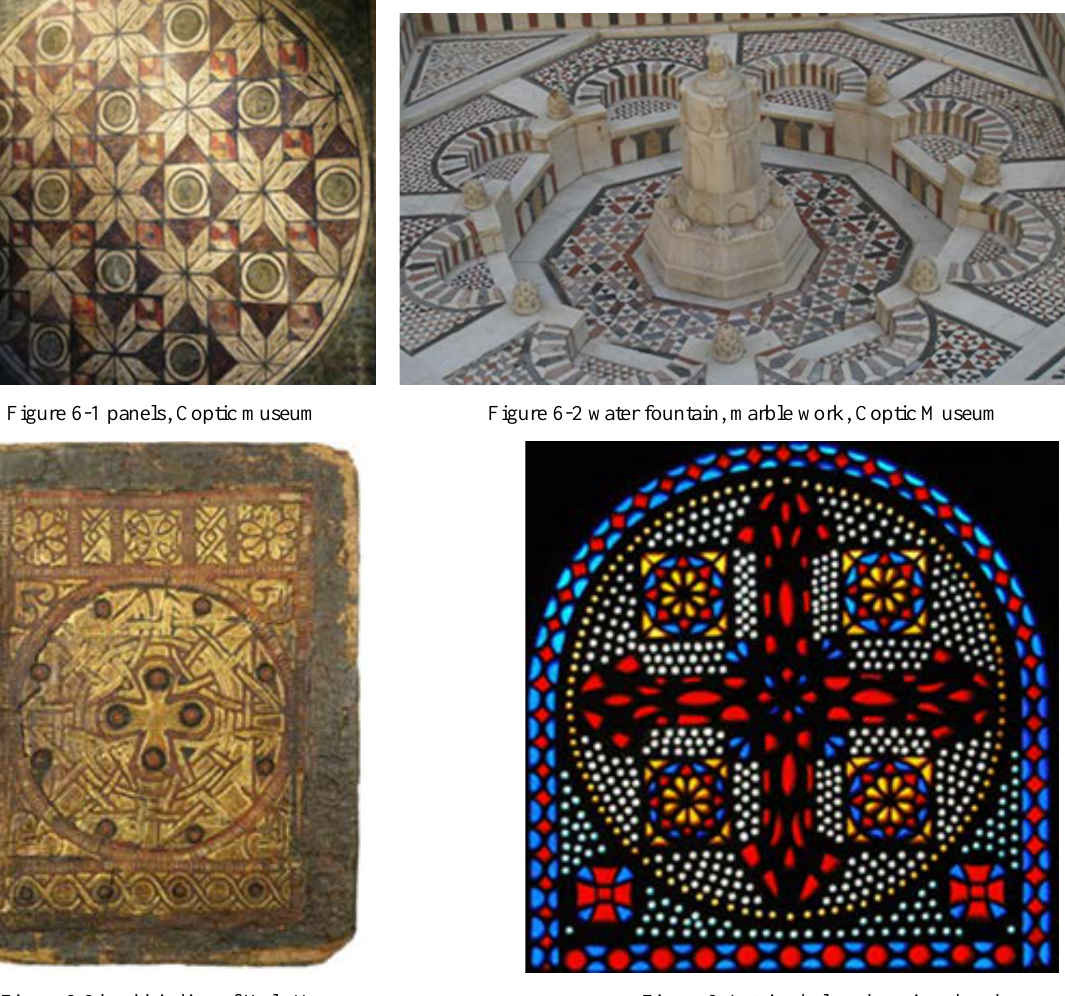
Figure 6-3 bookbinding of Holy Mary Figure 6-4 stained glass, hanging